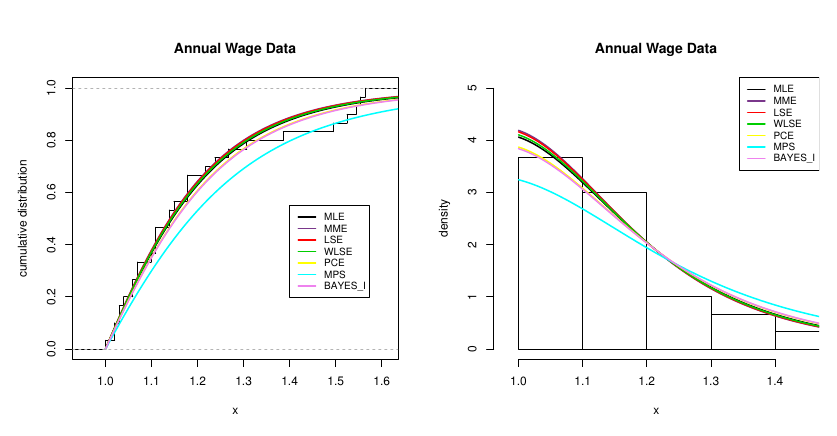
Figure 7 – The empirical CDF and histogram with the fitted CDFs and PDFs. R